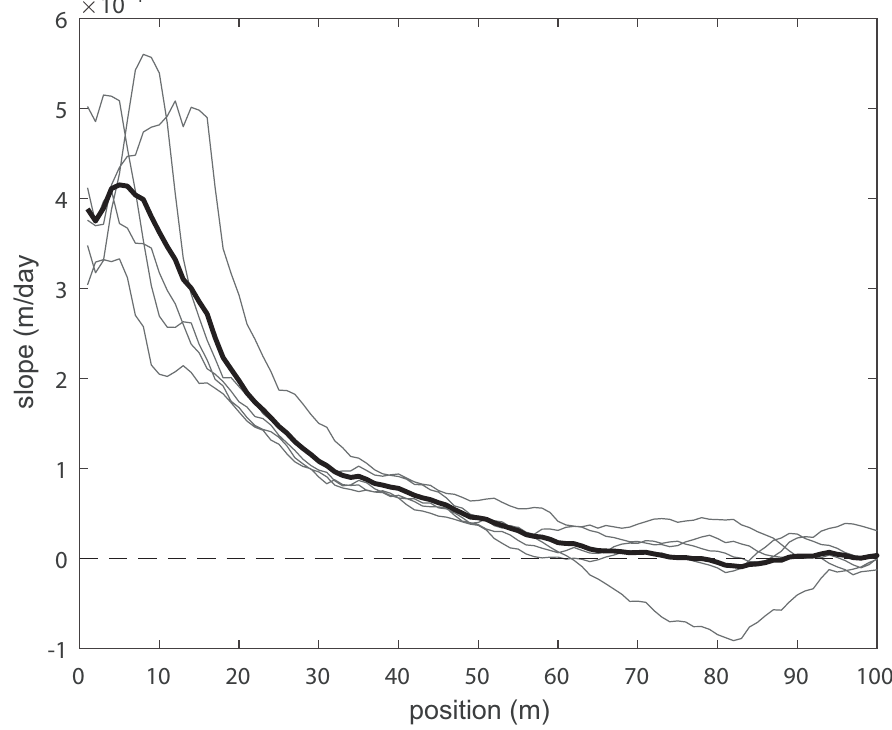
Figure 7. Estimation of the progradation rate as a function of the position along the Coastal Division profiles. Gray lines correspond to the slopes estimated separately for the five profiles, while thick black line gives the corresponding average